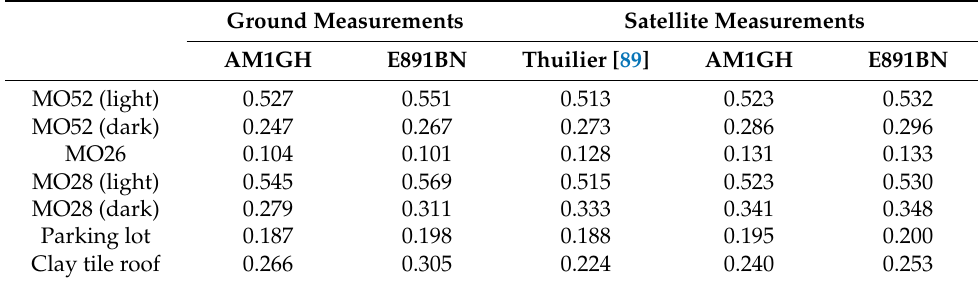
Table 6. Ground and satellite solar reflectance measurements with different reference